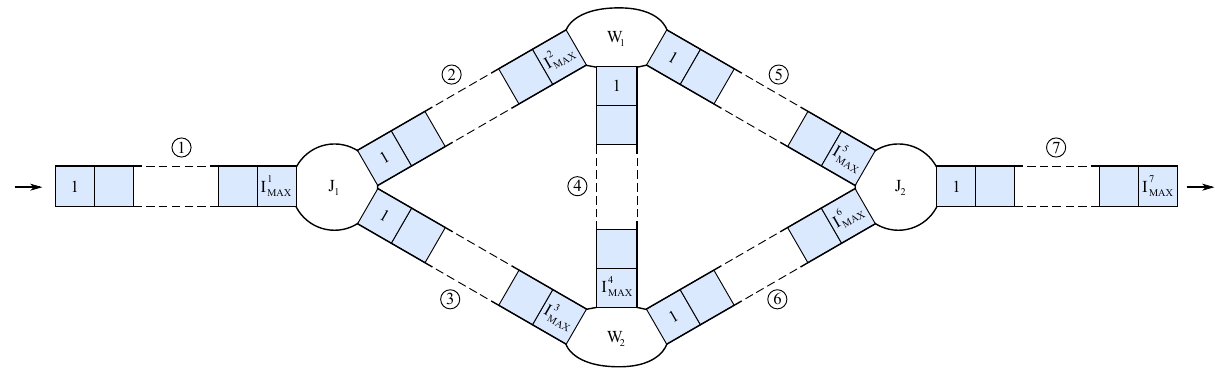
Figure 12. Pressurized transient in a pipe junction. Pressured head vs time x = 500 m (red), x = 1000 m (green) and x = 5000 m (blue).